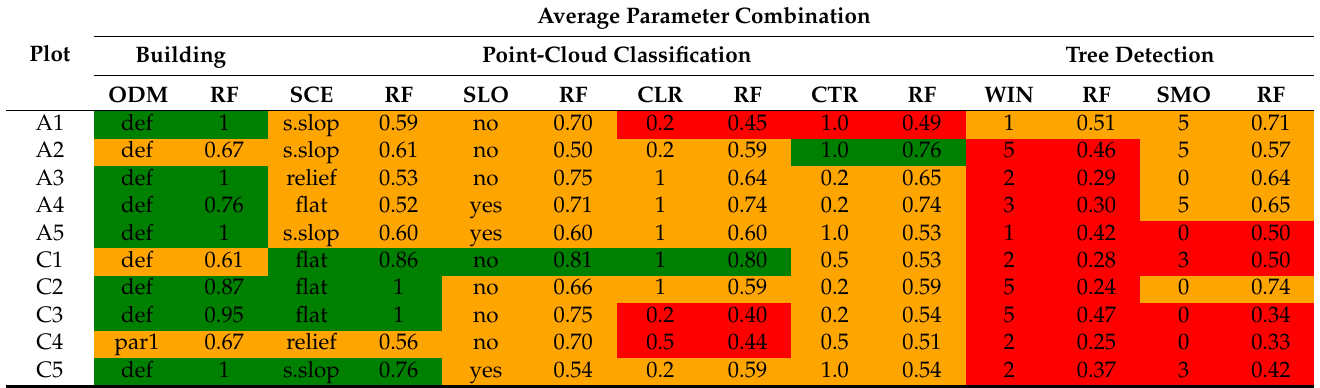
Table 5. Ideal combination parameters with averaged relative-frequency values, to improve tree characteristics and density